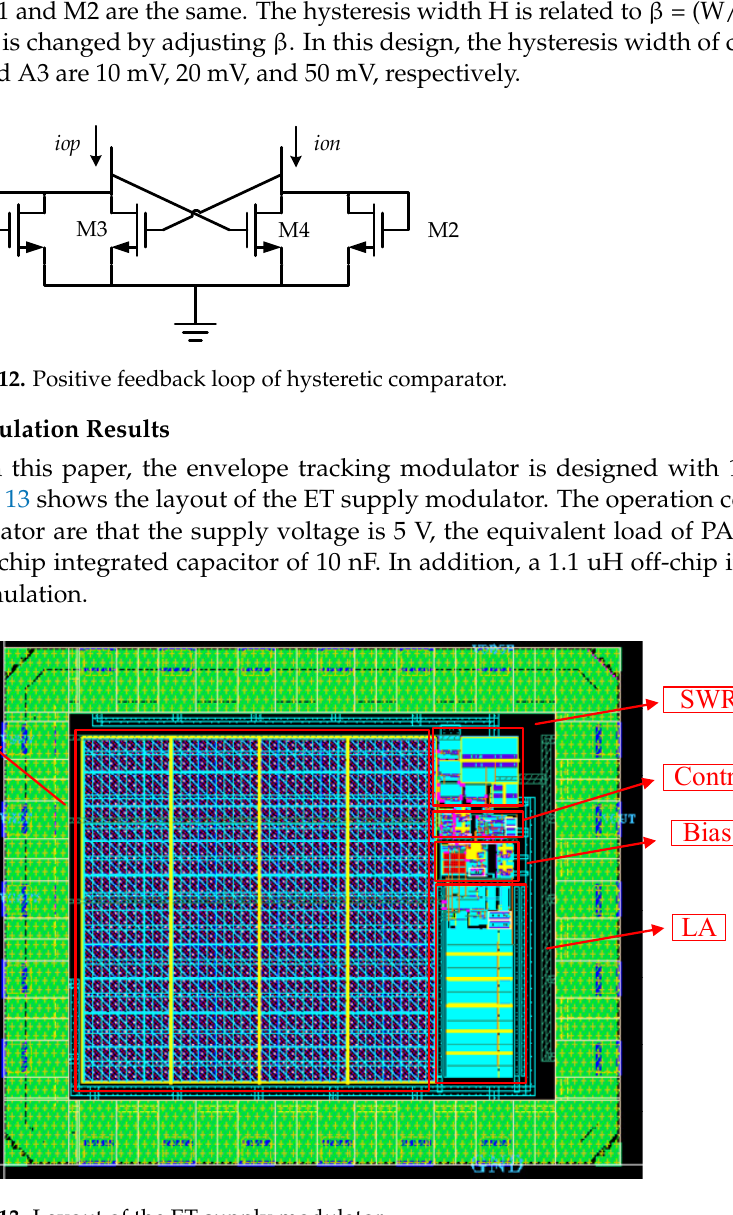
Figure 13. Layout of the ET supply modulator.